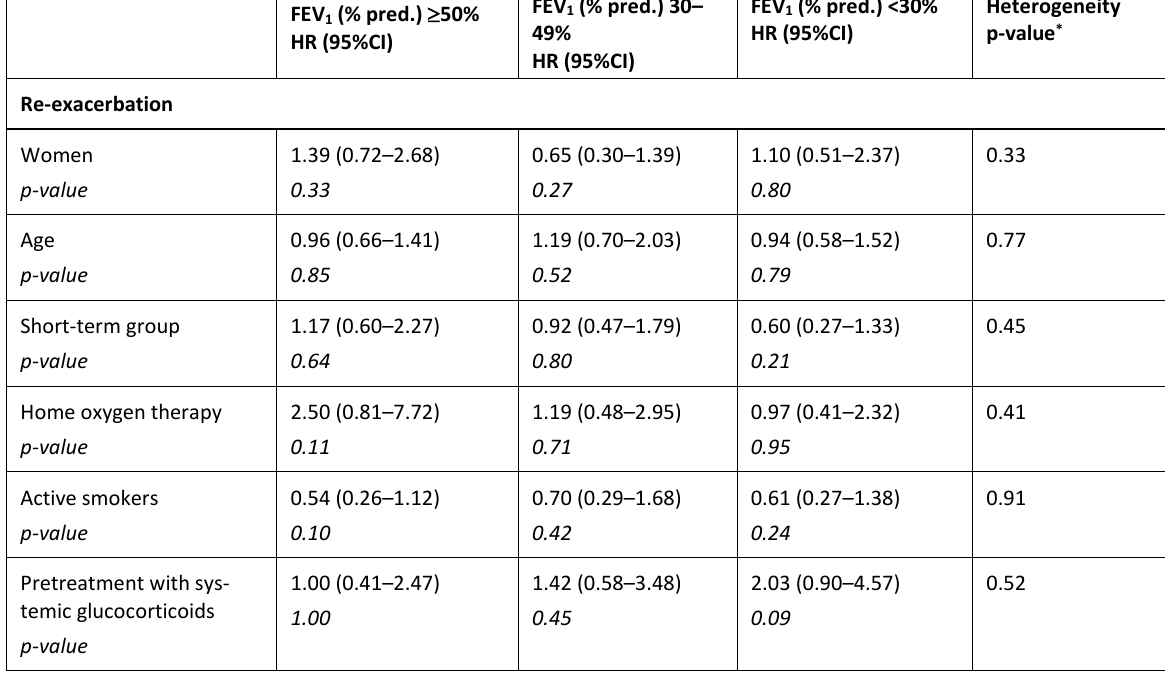
Table S3A: Multivariate analysis of time to re-exacerbation or re-exacerbation and/or death stratified by FEV 1 at